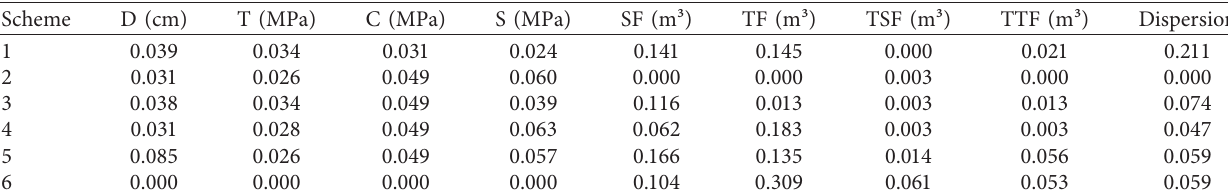
Table 6: Coordination degrees of the basic elements of six